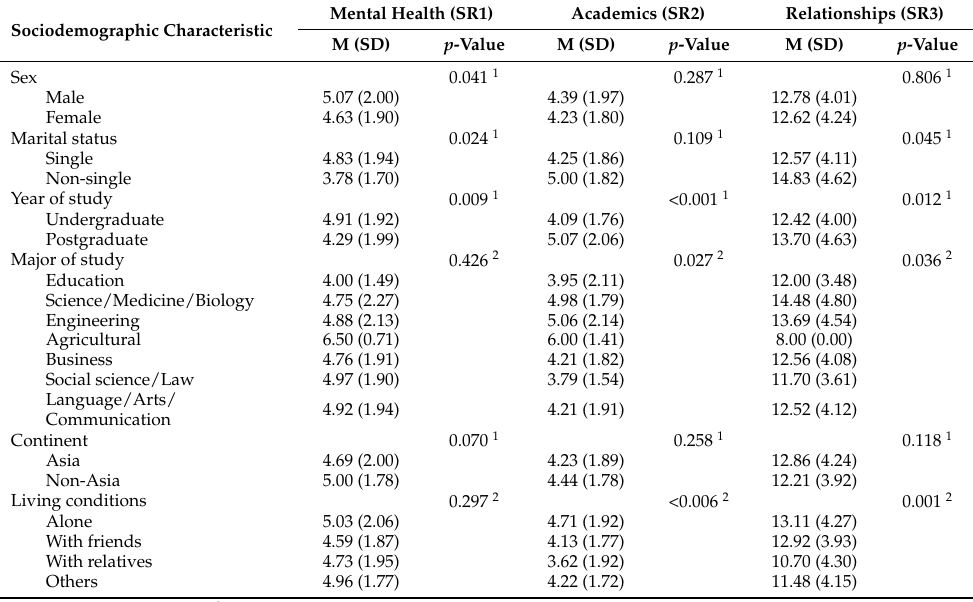
Table 6. Resilience scores across sociodemographic characteristics among respondents (N = 383).